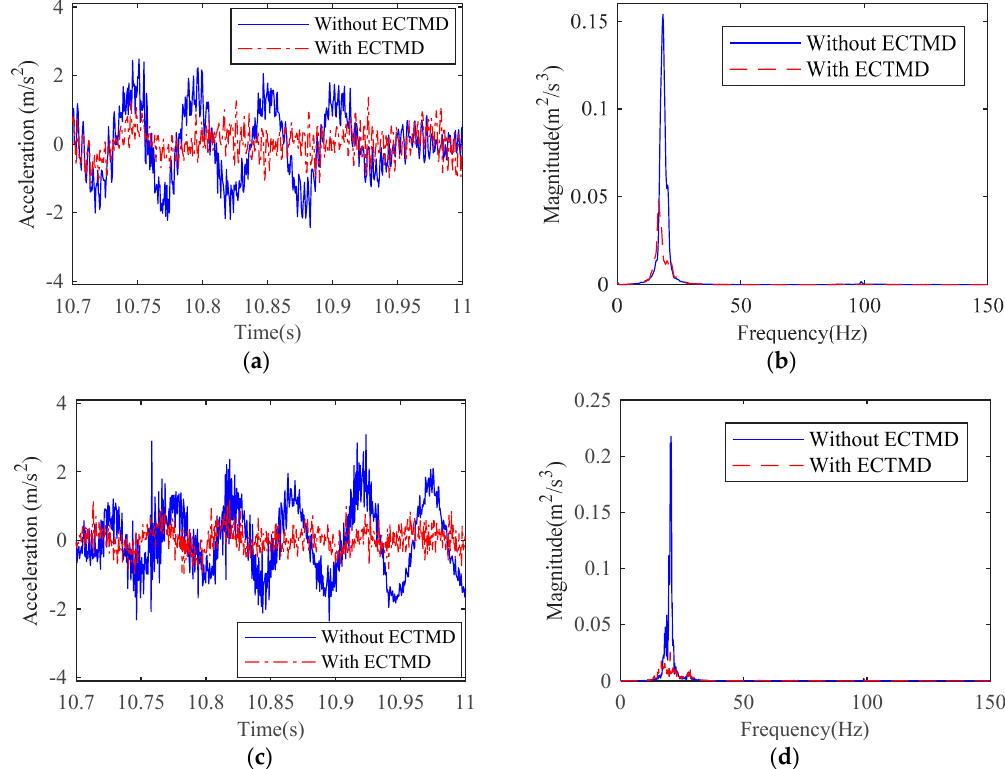
Figure 15. Acceleration response under wind speed of 24.7 m/s and wind direction angle of 0°. ( a ) Along-wind time history; ( b ) Along-wind Power-spectral density of acceleration; ( c ) Across-wind time history; ( d ) Across-wind power-spectral density of acceleration.